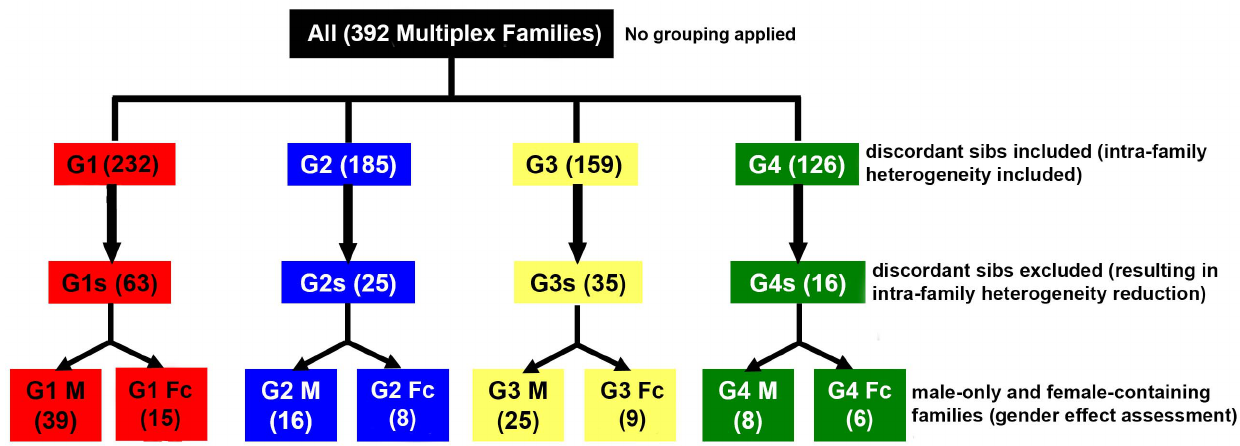
Figure 1. Description of the stratification protocol used in this study. The 4 original sub-phenotypes (denoted by four different colors) were further stratified by removal of families containing affected siblings of another sub-phenotype to yield the Gs level subgroups. These subgroups were further divided according to male only or female-containing pedigrees. Due to intra-family heterogeneity in multiplex cases, some families were included in more than one stratified group. Therefore, the sum of individual and family numbers in subgroups exceeds the numbers listed for the